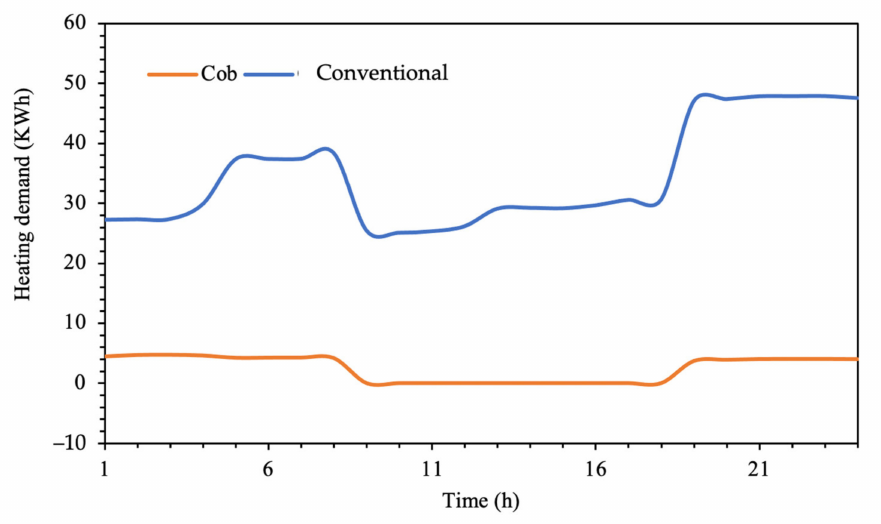
Figure 20. Heating demand for cob and conventional